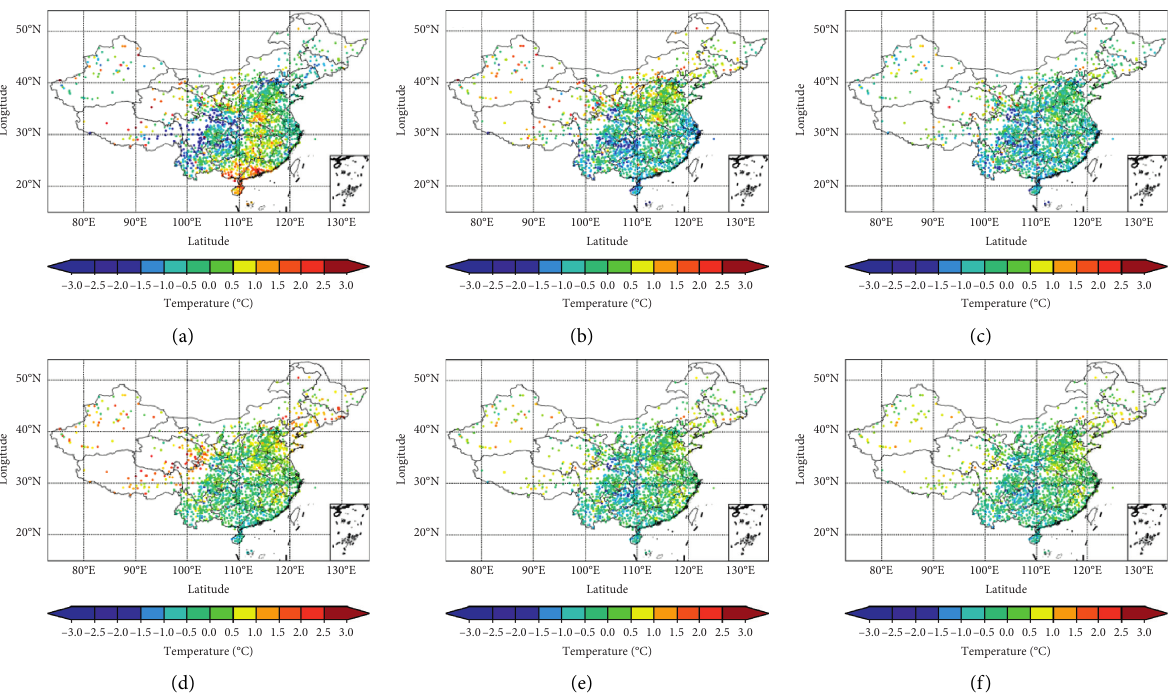
Figure 9: Spatial distribution of bias for six machine-learning models. (a) MLR-Bias. (b) RF-Bias. (c) KNN-Bias. (d) DNN-Bias. (e) GBTD- Bias. (f) XGB-Bias.